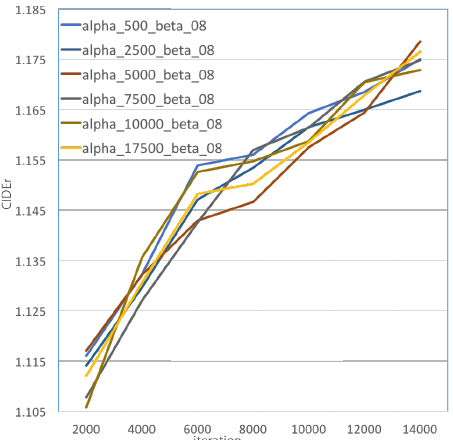
Figure 6. The CIDEr scores of the WG-ASCST model with different h history rewards. The x -axis is the number of iterations, and the y -axis is the CIDEr score.